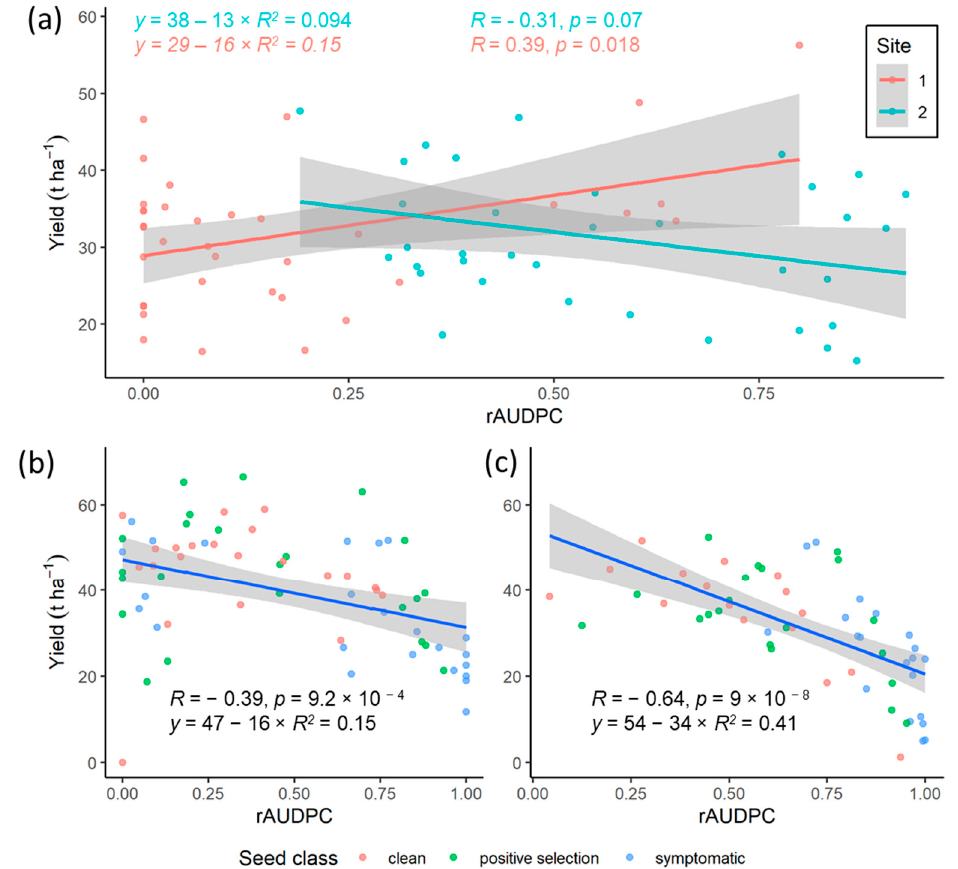
Figure 5. Linear regression with Pearson correlation of relative AUDPC (rAUDPC) and yield of varieties at two sites in season 2018–2019 ( a ) and with three different seed classes, in the 2019–2020 season ( b ) and 2020–2021 season ( c ). Regression line equations are presented in-panel, and grey margins indicate 95% confidence fits.